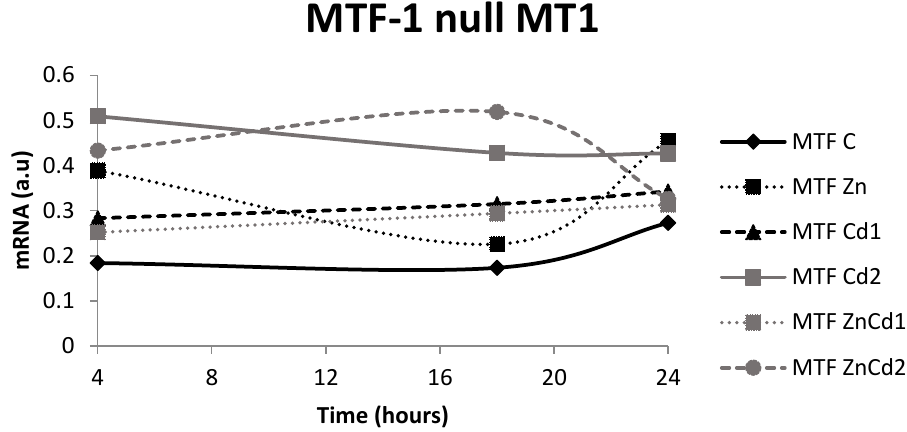
Figure 7. mRNA in arbitrary units (a.u.) of the MT-1 gene in the MTF-1 null strain. C = Control; Zn = Zn 50 µM; Cd 1 = Cd 1 µM; Cd 2 = Cd 2 µM; ZnCd 1 = Zn 50 µM + Cd 1 µM; ZnCd 2 = Zn 50 µM + Cd 2 µM.